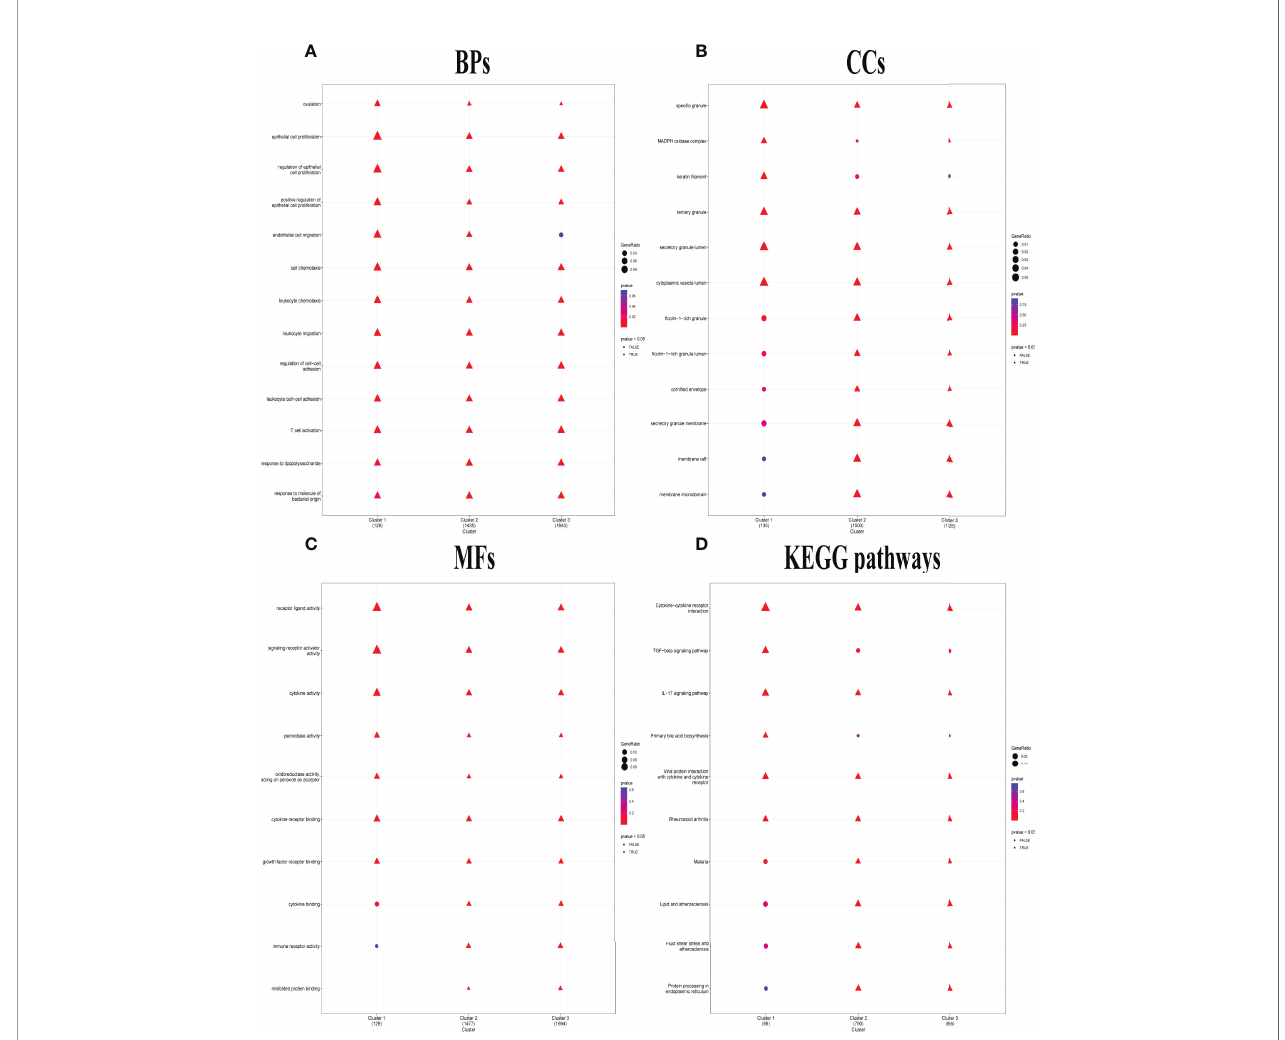
FIGURE 5 | Distinct biological functions identi fi ed among the three pyroptosis-related clusters. (A – C) Comparison of the GO-BPs (A) , GO-CCs (B) , and GO-MFs (C) enriched in the three clusters. GO, Gene Ontology; BP, biological processes; CC, cellular components; MF, molecular functions. (D) Kyoto Encyclopedia of Genes and Genomes (KEGG) pathways enriched in the three clusters. The terms with p -value <0.05 were shown as triangle points (TRUE), and others were displayed as round points